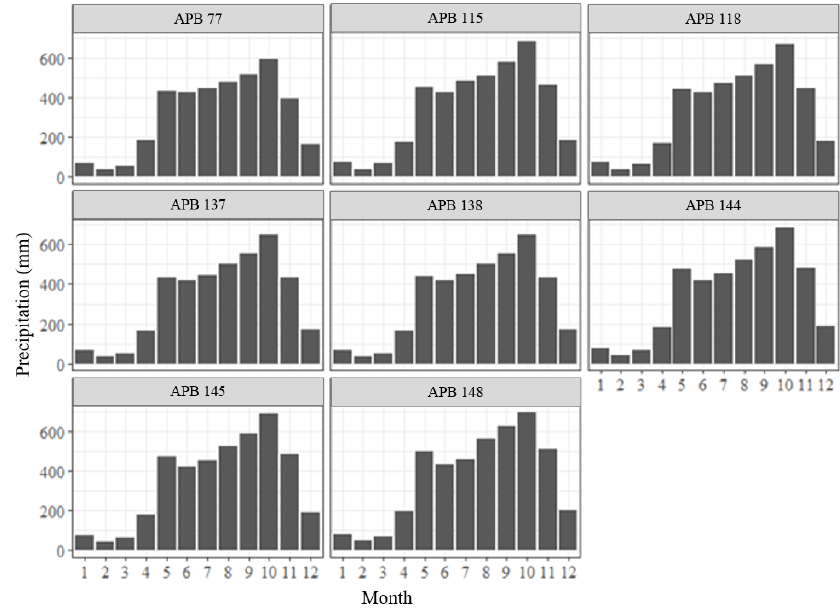
Figure 7. Monthly precipitation regime in each selected APBs from 1995 to 2015.